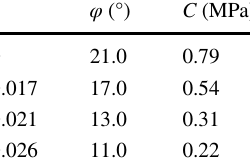
Table 3 Parameters of